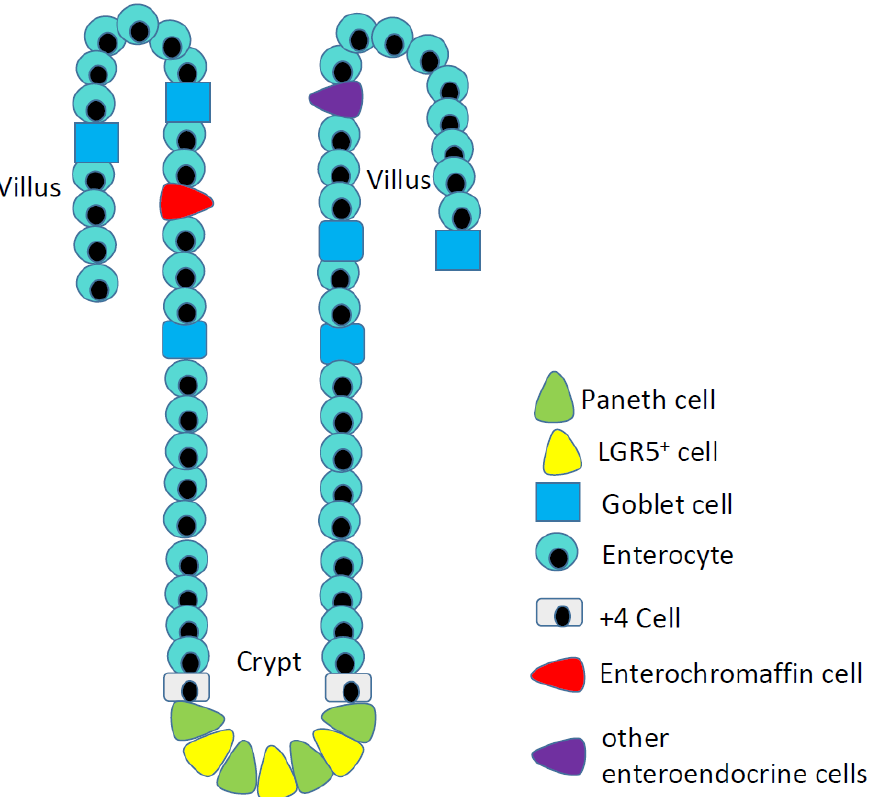
Figure 1. Epithelial cells of the ileum, including the rare serotonin-producing enterochromaffin cells (red cells) that are the origins of ileal neuroendocrine tumors.